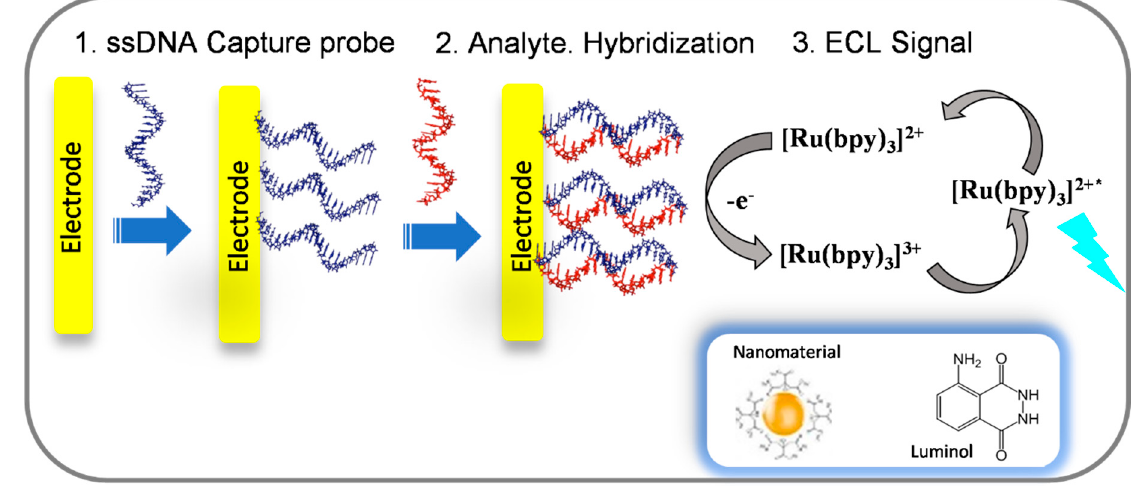
Figure 9. General scheme of ECL DNA Biosensor based on [Ru(bpy) 3 ] 2+ .